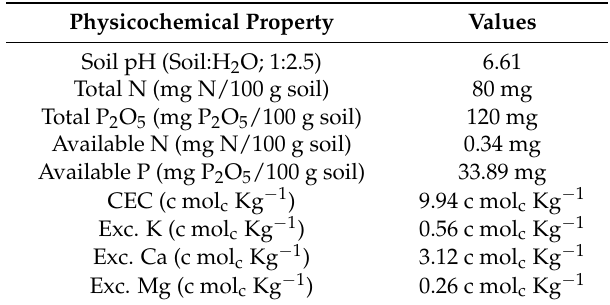
Table 3. Physicochemical properties of Futsukaichi soil.